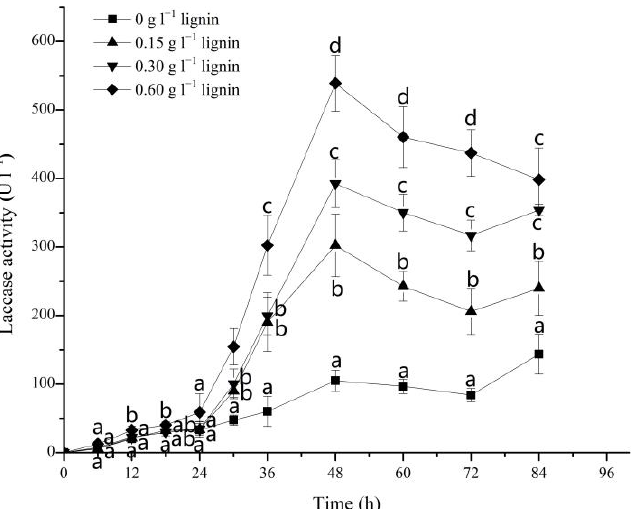
Figure 3. Laccase activities during the DR5B decolorization process by G. lucidum EN2 in the presence of different contents of alkali lignin (0, 0.15, 0.30, and 0.60 g L − 1 ). The vertical line on each bar indicates the standard deviation for three replicates (SD, n = 3). Different letters represent significant differences between treatment groups at each time point, as determined with two-way ANOVA followed by LSD or Tukey multiple comparison tests ( p < 0.05).